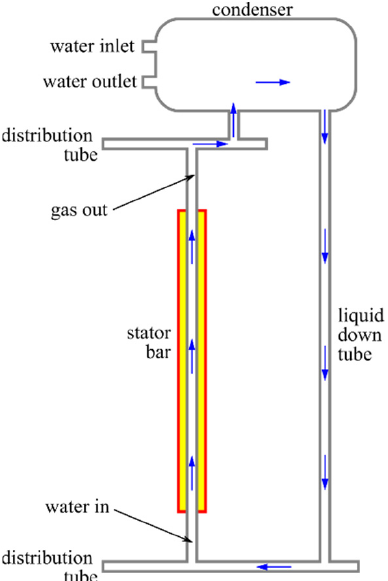
Figure 21. Evaporative cooling system principle [111].